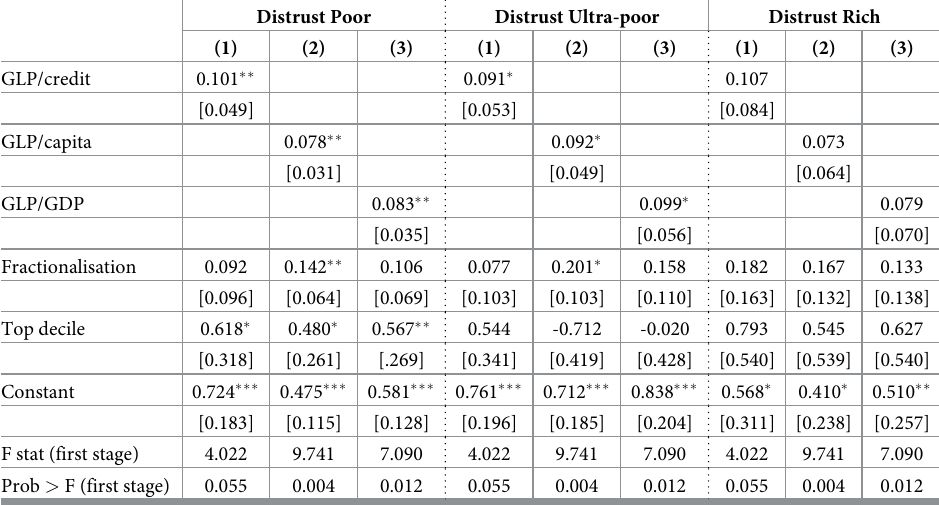
Standard errors in brackets. �